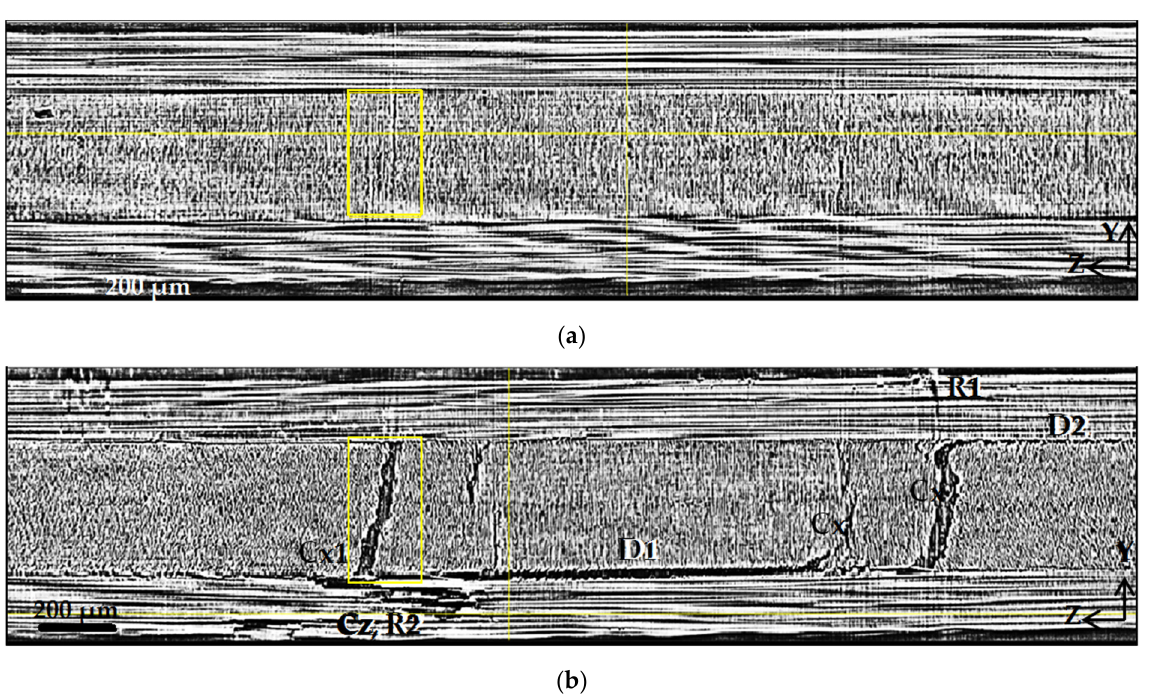
Figure 9. Transverse ZY1 slices ( a ) and ZY2 ( b ) marked in Figures 6 and 7. D1 and D2 indicate delamination at interfaces 3–4 and 1–2, respectively; Cx—transverse cracks spreading along the X-axis in 90° plies, Cx1—crack indicated in Figures 6 and 7; Cz—vertical cracks along the Z-axis in 0° plies; R1 and R2—rupture of fibers.